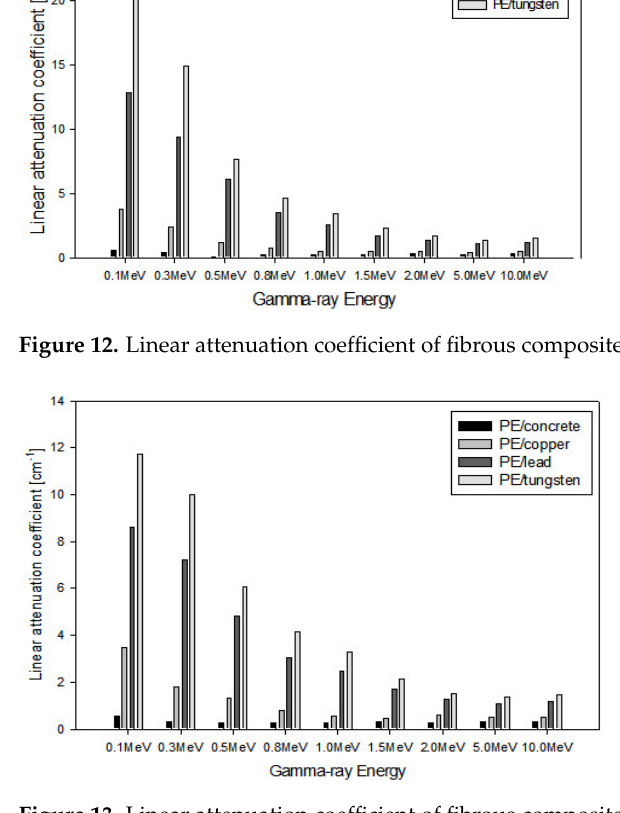
Figure 13. Linear attenuation coefficient of fibrous composite; fiber diameter 0.1457 cm.